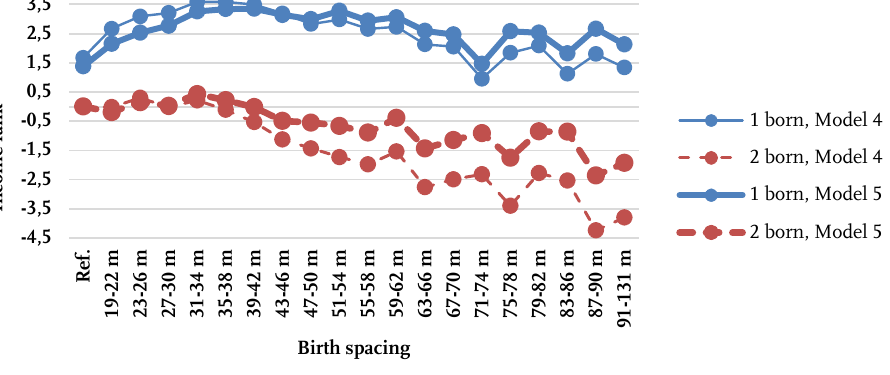
Panel D: Estimates from models 5 and 6, household income rank